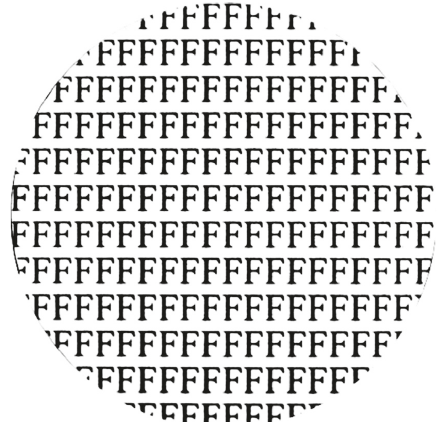
Figure 9: Original image of the F target before liquid injection.